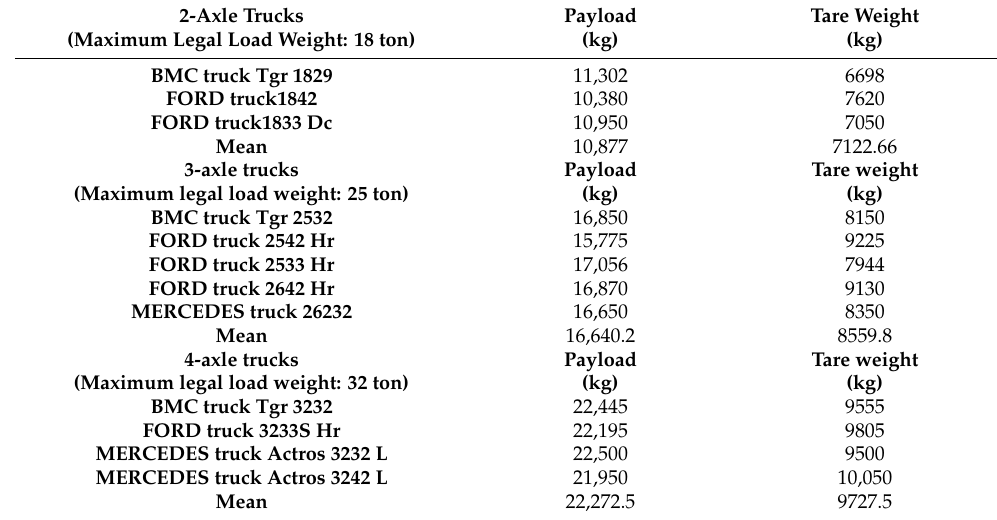
Table 15. The 2-axle truck, 3-axle truck and 4-axle truck mean payload and tare weight values.